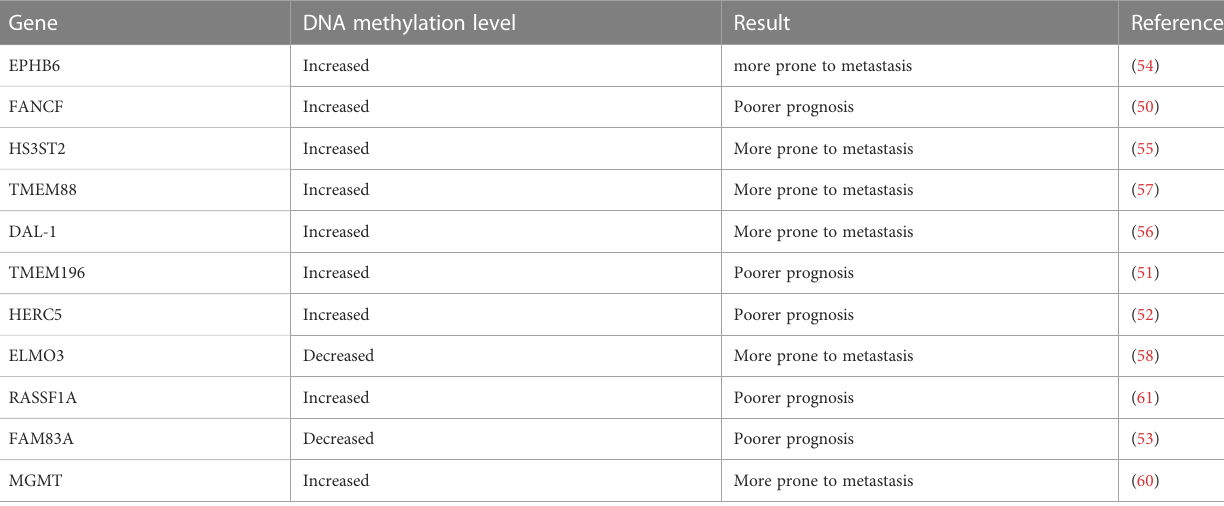
TABLE 2 Association of DNA methylation genes with prognosis and metastasis in non-small cell lung cancer. Gene DNA methylation